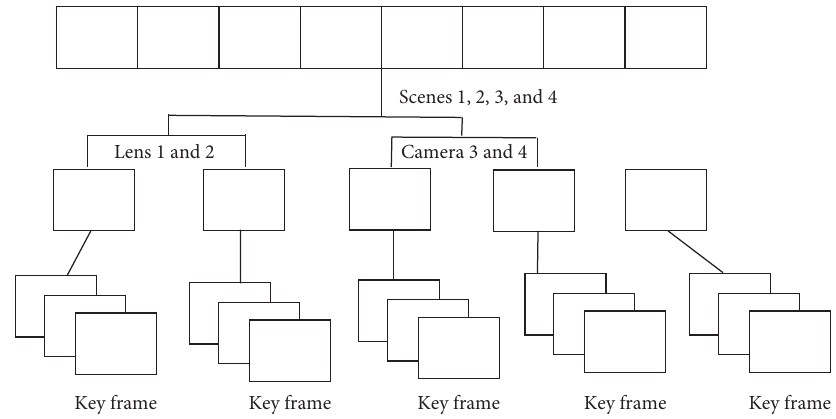
Figure 5: Video layered structure diagram.